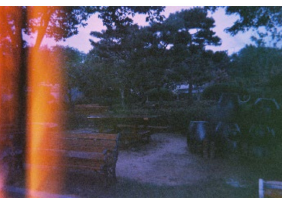
Figure 5. Space in the social welfare center.